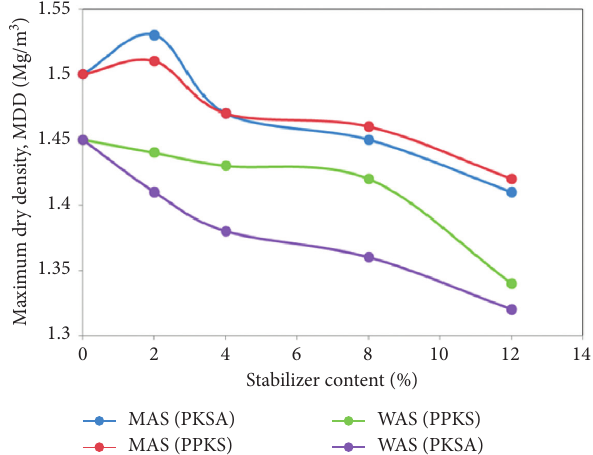
Figure 6: Maximum dry density (MDD) versus PKSA and PPKS for the treated shale at MAS and WAS methods.